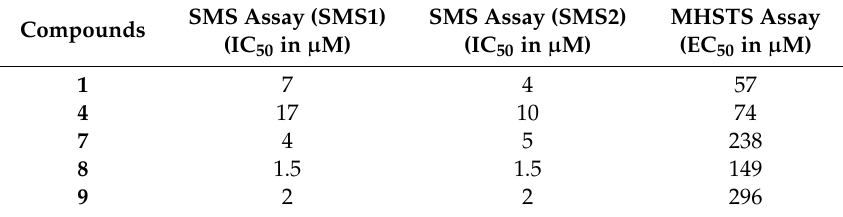
Table 1. Inhibitory activities of DCA, its derivatives, and natural sphingomyelin synthase towards SMS activity and A β 42